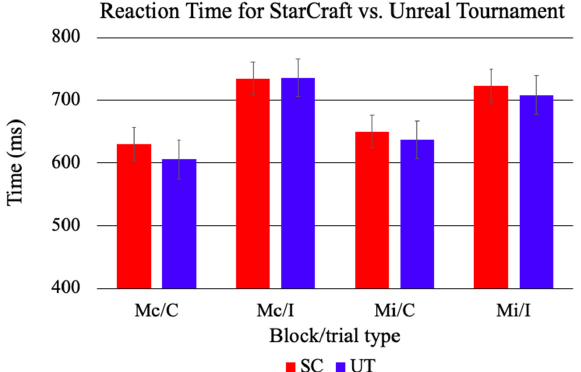
Figure 2. Mean reaction times in the CStroop for SC and UT. The participants for both UT and SC had slower reaction times in I trials in comparison to C trials. I trials were responded to faster in the Mi block and C trials were responded to slower in the Mi block in comparison to the Mc block. There were no significant differences.